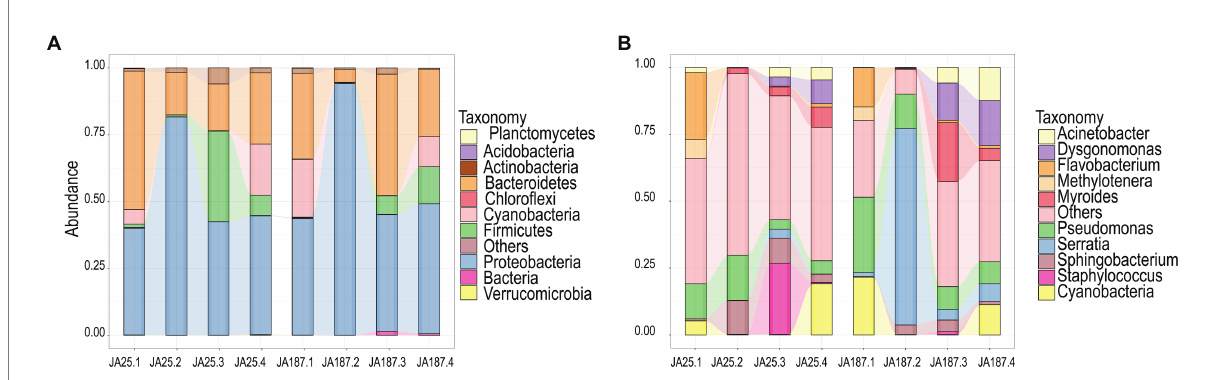
FIGURE 3 Demonstration of the composition of two Jerusalem artichoke resources at the phylum and genus level during storage. (A) phylum level (B) genus level. Each bar represents the relative abundance in each sample. Each color represents a particular phylum or